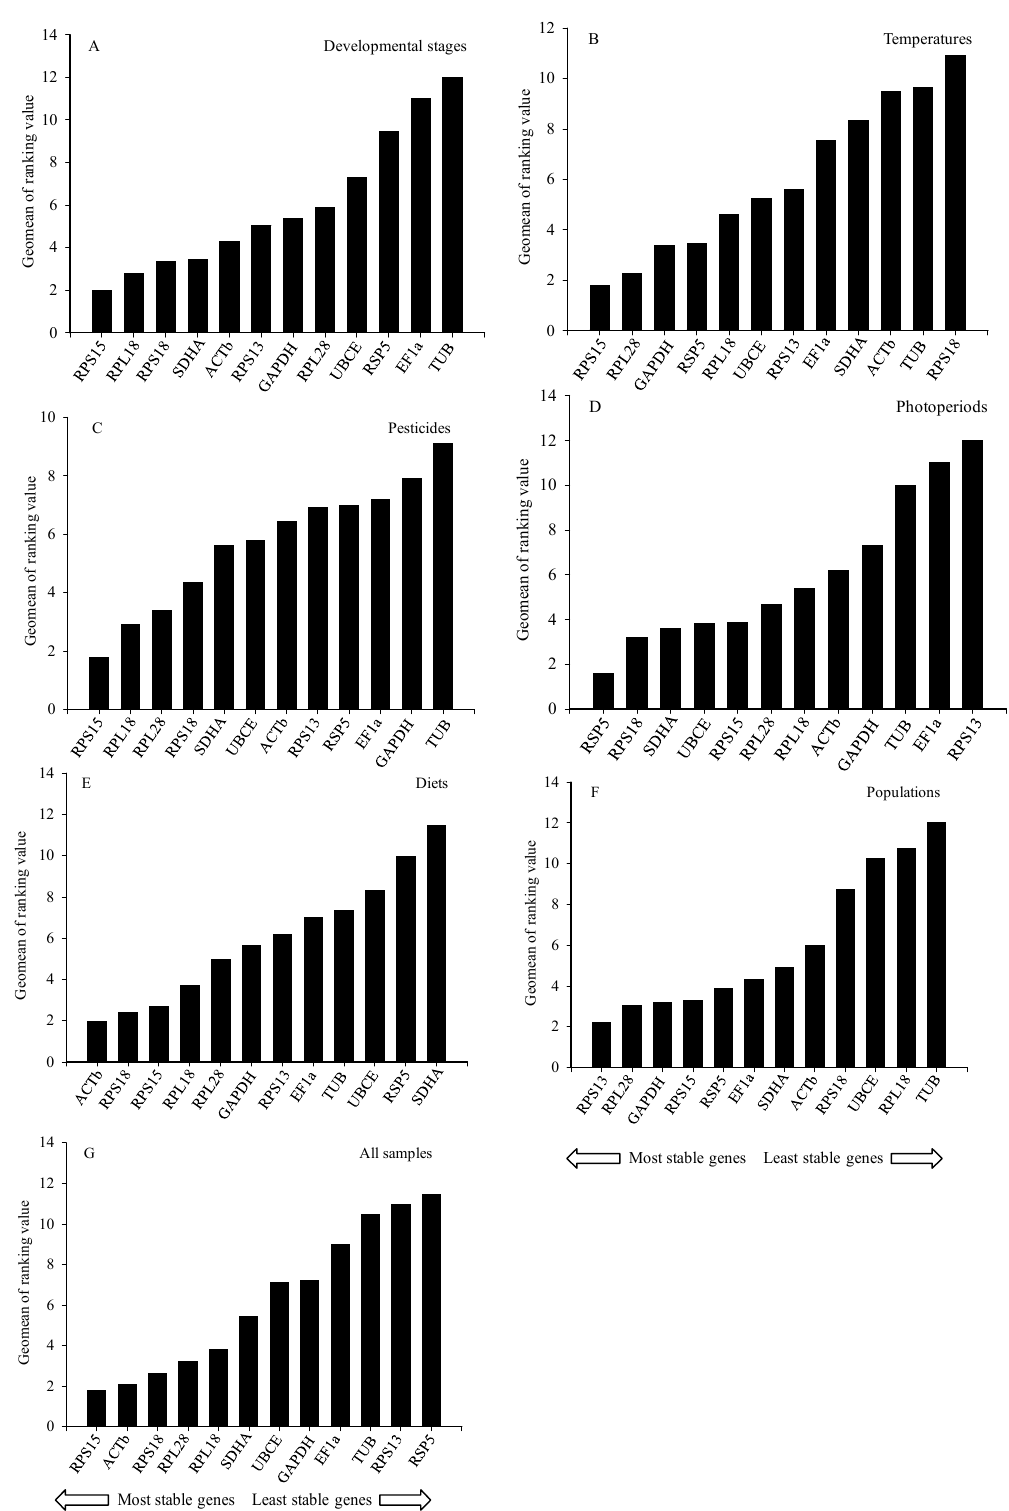
Figure 3. The stability of the 12 housekeeping genes in B. odoriphaga based on the Geomean method of RefFinder and measured across: ( A ) developmental stages (from adult to pupa); ( B ) temperatures; ( C ) pesticides; ( D ) photoperiods; ( E ) diets; ( F ) B. odoriphaga populations; and ( G ) all samples. For ( B – F ), 4th-instar larvae were used.